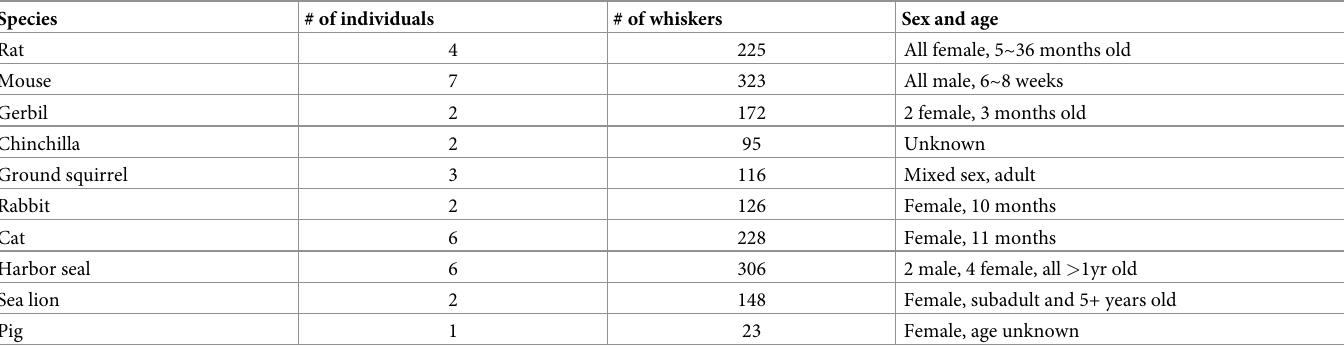
Table 1. The number of whiskers and specimens used in this